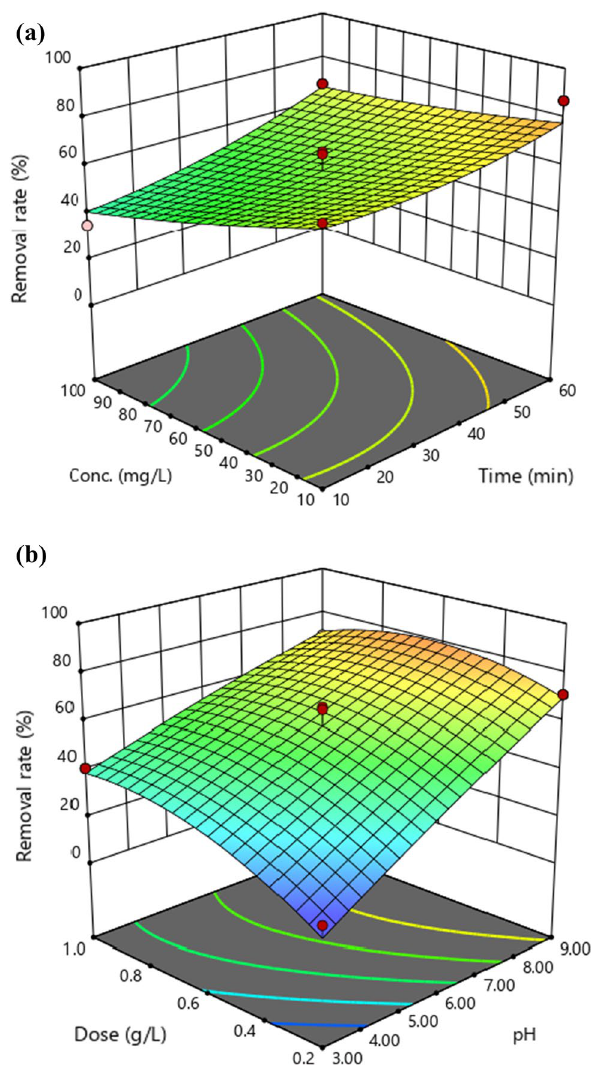
Fig. 6 Response surface plot about the effects of a Conc. vs. time, b dose vs.